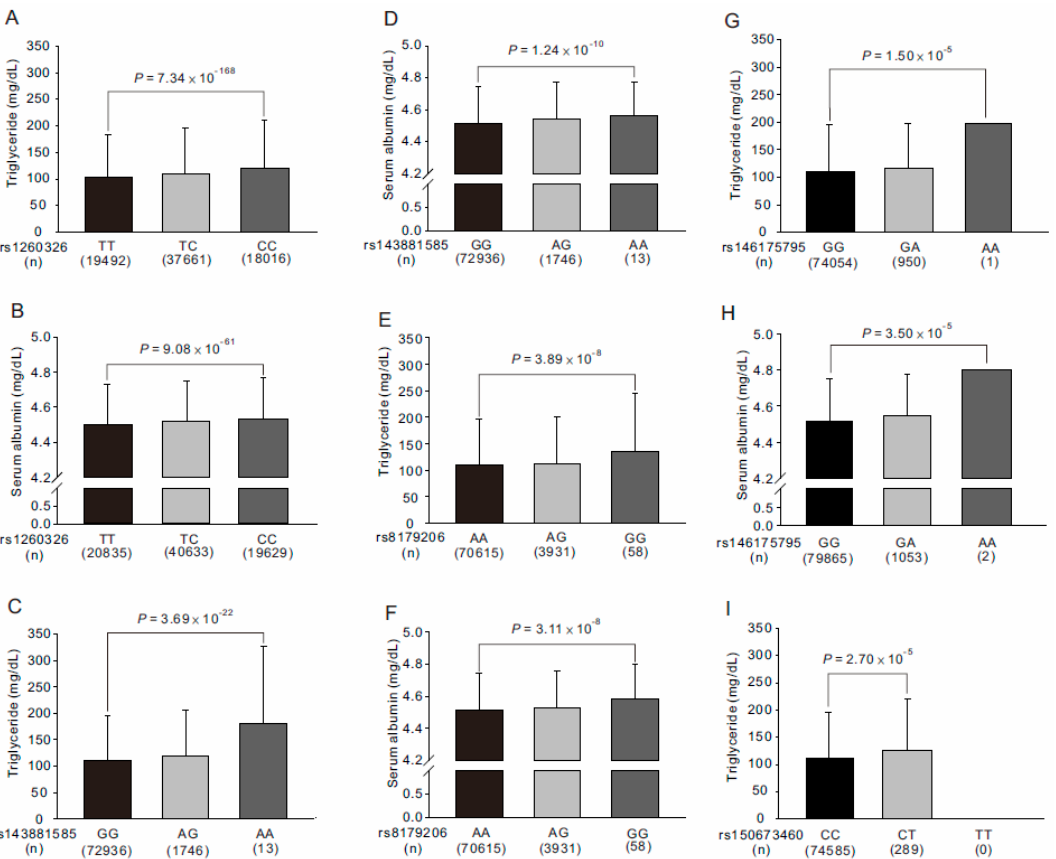
Figure 4. Association of GCKR exonic mutations with serum triglyceride ( A , C , E , G , I ) and albumin ( B , D , F , H ) levels in Taiwan Biobank project participants. Further adjusted for rs1260326 genotypes in conditional analysis ( C , D ). Further adjusted for rs1260326 and rs143881585 genotypes in conditional analysis ( E , F ).